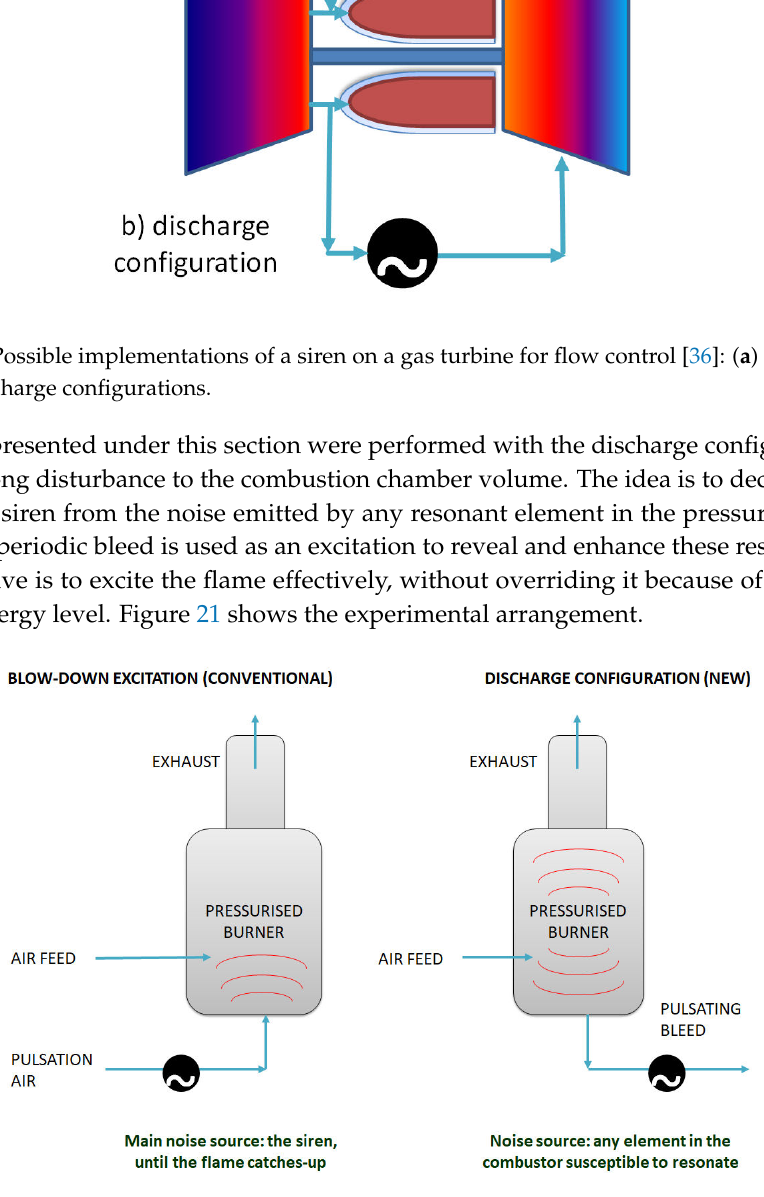
Figure 21. Functionality of siren configurations on the pressurised test